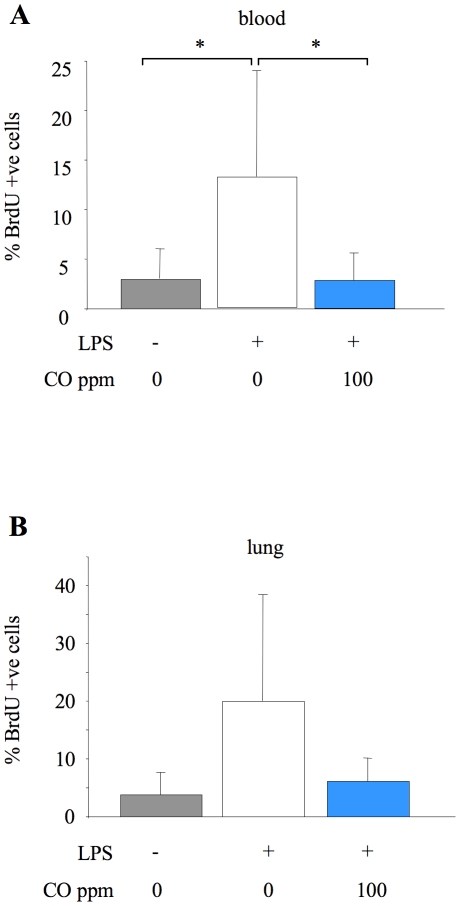
Neutrophil mobilisation.Percentage of newly released BrdU containing neutrophils in blood (A) and lung tissue (B) from untreated mice (no LPS or CO), or mice exposed to 0 or 100 ppm carbon monoxide (CO) for 6 hours after LPS instillation. Neutrophils were identified as described previously, and BrdU incorporated into DNA was detected by flow cytometry using an APC-labelled anti-BrdU antibody. Data are expressed as percentage of neutrophils within tissue positive for BrdU staining. *p<0.05 vs LPS +0 ppm CO; n = 6–7/group.